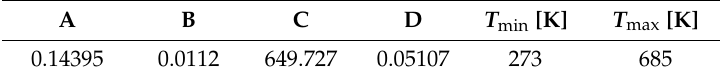
Table 2. Parameter for the water density equation with T [K]